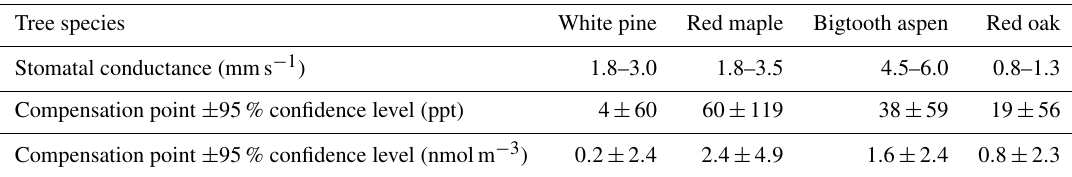
Figure 6. Scatter plots of foliar NO 2 deposition velocity ( v dNO ) vs. stomatal conductance of water ( g H ) for (a) white pine, (b) red maple, 2 2 O (c) bigtooth aspen, and (d) red oak. The data points and their error bars are represented by the black symbols. The solid and dashed red lines are the best-fit linear regression and the 95% confidence bounds, respectively. The solid blue line shows the relationship between the deposition velocity and the stomatal conductance if NO 2 loss is entirely controlled by the stomata. The slope of the blue line is 0.62, the square root of the ratio of the molecular weight of water to NO 2 . Listed in each subplot under the tree name are the Pearson correlation coefficient ( ρ ) and the slope ( m ) and intercept ( b ) of the best-fit linear regression line. Table 2. Compensation points from the flux vs. concentration linear fits in Fig. 7. The ranges of the stomatal conductance of the data used are also